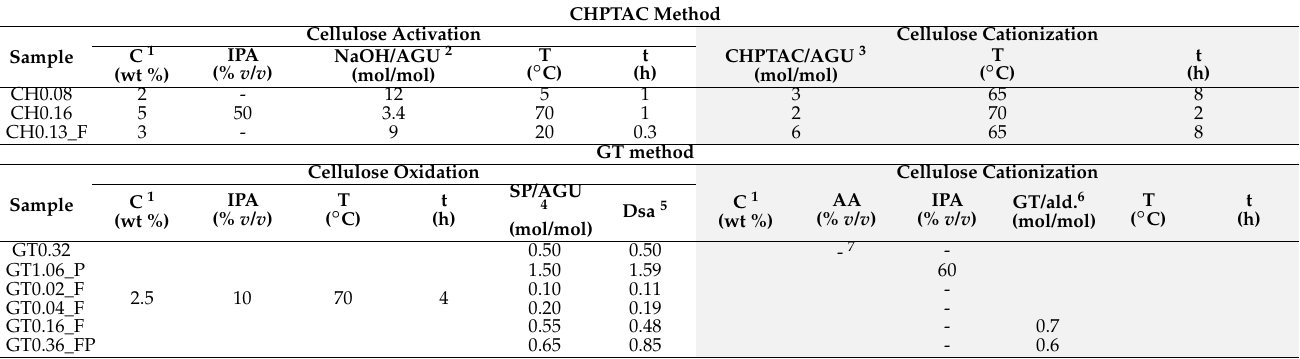
Table 1. Reaction conditions used for the cationization of BEKP with CHPTAC and